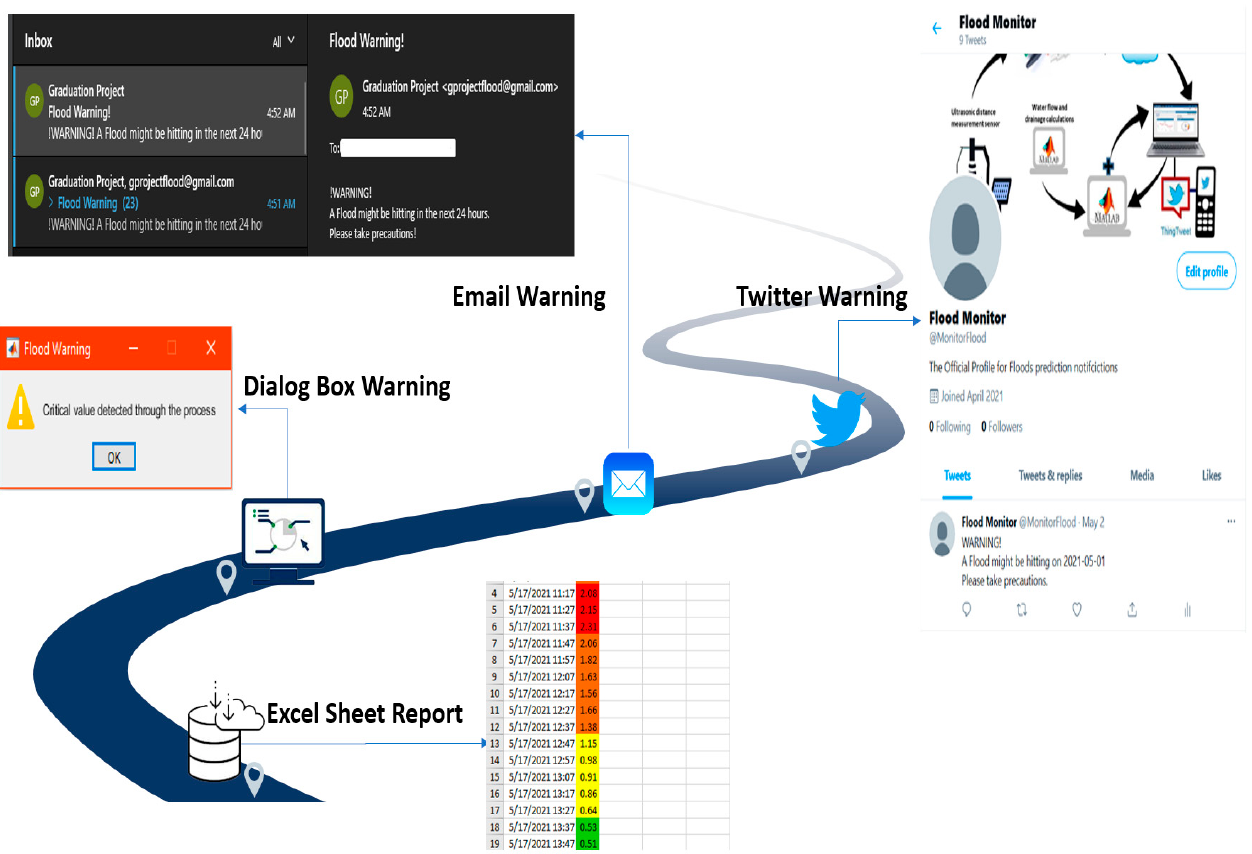
Figure 11. The warning alarm notifications.